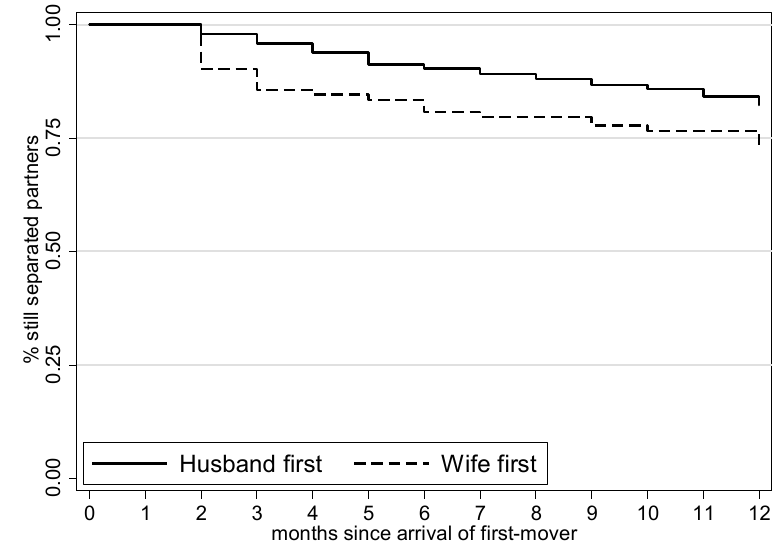
Figure A1 : Kaplan-Meier survival estimates of reunification with left-behind partner by sex of